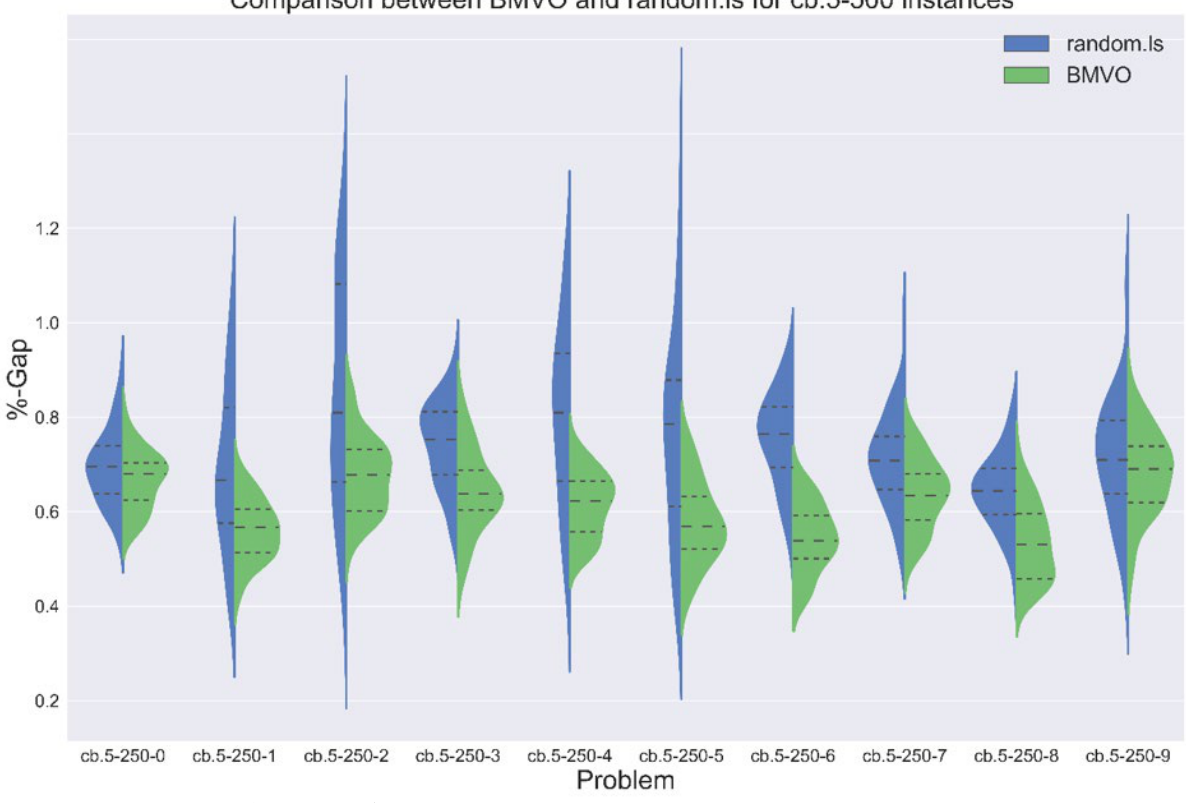
Figure 3. Evaluation of percentile binary operator with Local Search